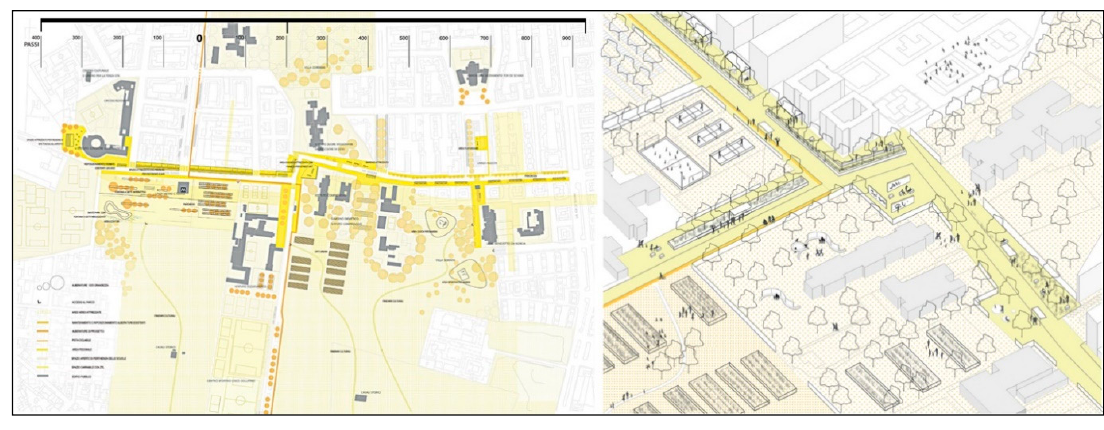
Figure 7. Rome Node Teano Metro C; the central location of the Teano metro station and the main cycling and walking routes and activities that can be carried out in the public space equipped for outdoor activities (Source: authors)